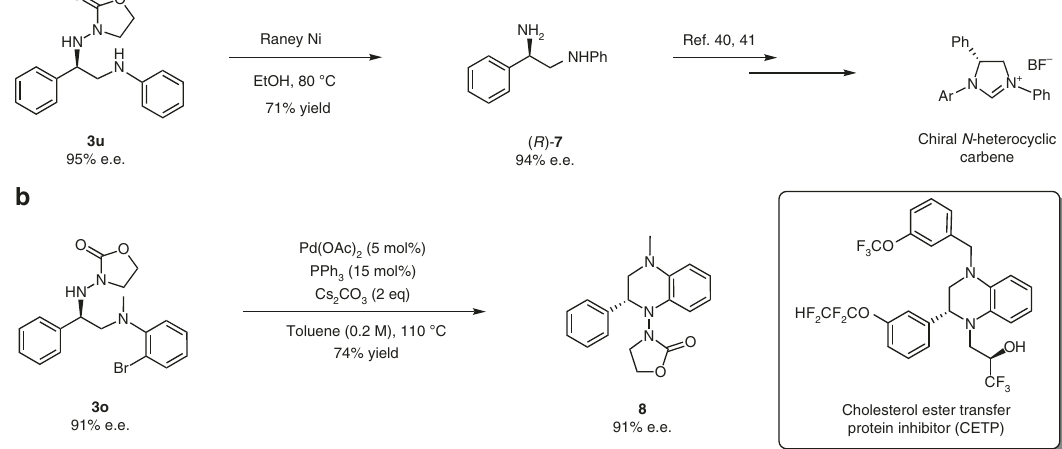
Fig. 6 Synthetic utility of the reactions. a Transformation of product 3u to chiral 1,2-diamine 7 . b Transformation of product 3o to dihydroquinoxazline